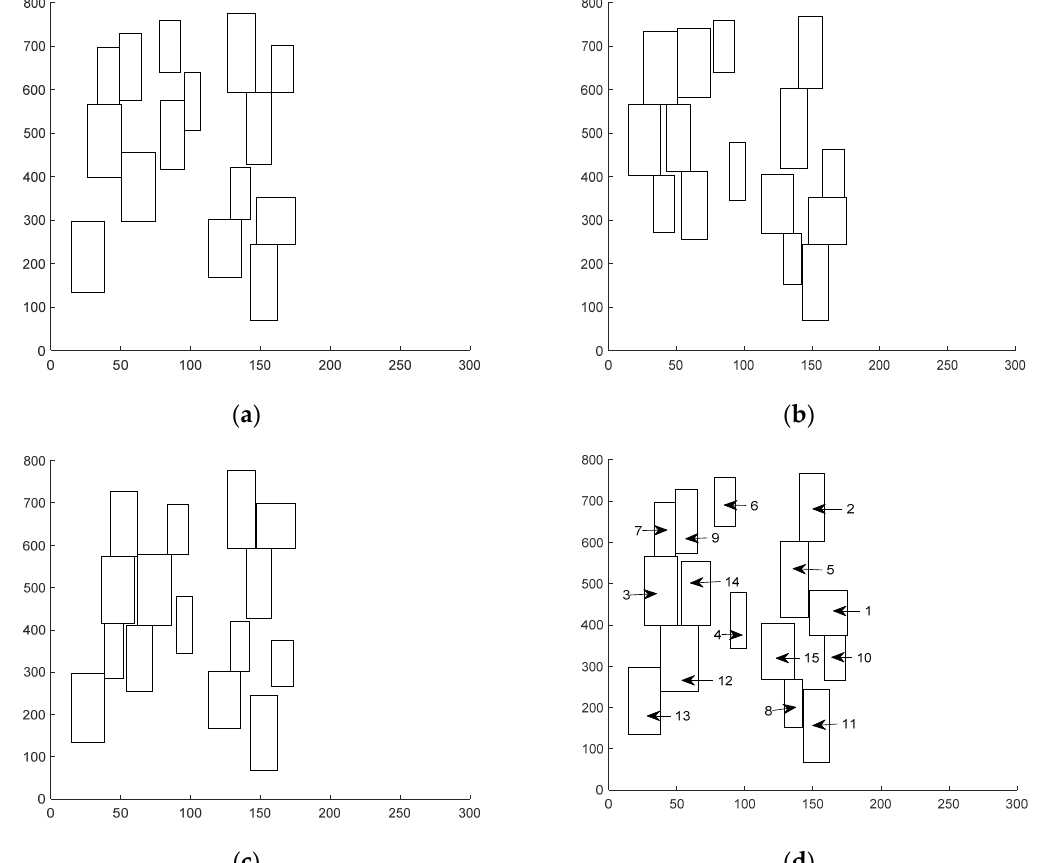
Figure 14. ( a ) Berthing plan (FCFS); ( b ) berthing plan (PSO); ( c ). berthing plan (PSO2); ( d ) berthing plan (MPSO). Table 3. Summary data of different approaches.